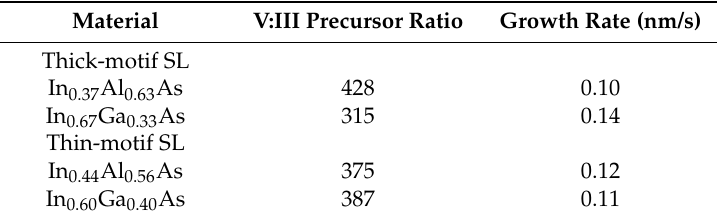
Table 1. Growth rates measured in calibration runs for III:V precursor ratios used to grow each superlattice